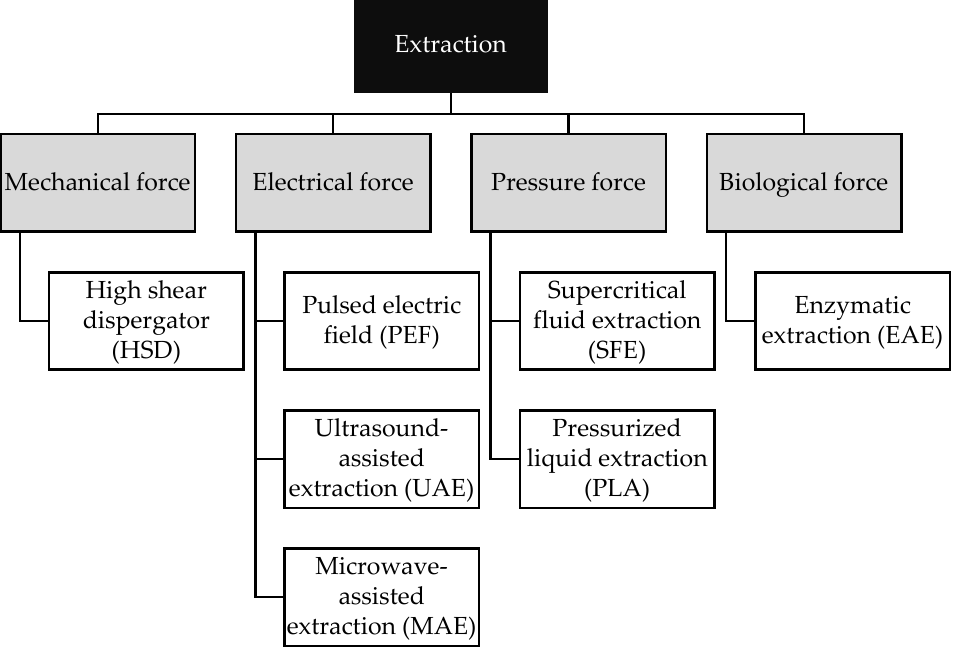
Figure 2. Scheme of the green extraction methods.